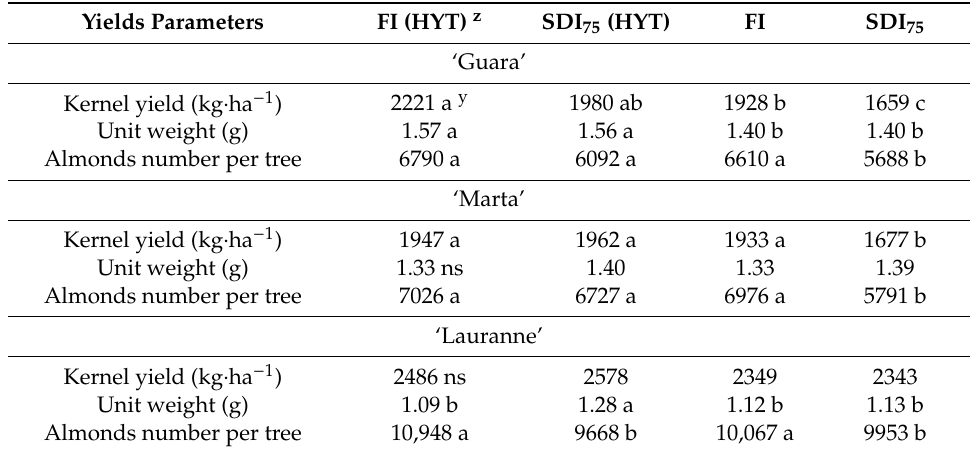
Table 6. Mean values of kernel yield, almond unit weight, and almonds number per tree for each cultivar subjected to irrigation and fertilization